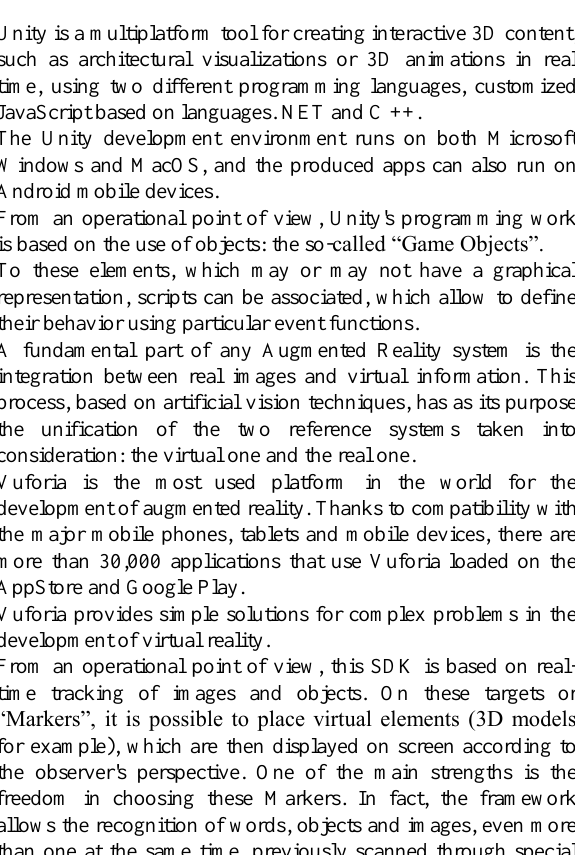
Figure 10. Mask reconstruction in